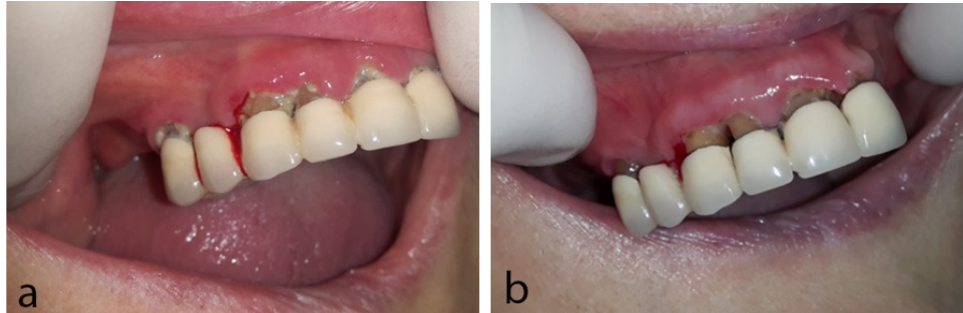
Figure 1. Case 1: ( a ) First clinical examination; spontaneous gingival bleeding and poor oral hygiene are noticed. ( b ) Follow-up at one week; amelioration of patient’s oral hygiene and remission of gingival bleeding.